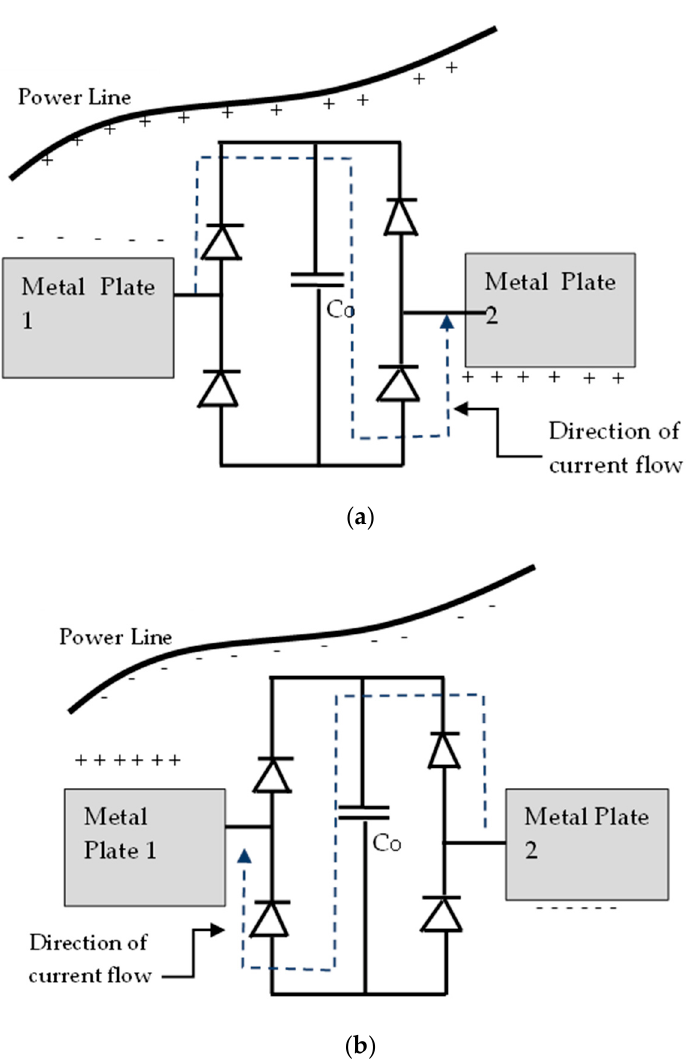
Figure 1. Induction of charges in the metal plates having different distances from the power line. Plate 2 is at a larger distance compared to plate 1. ( a ) Charge induced during +ve half cycle and ( b ) charge induced during -ve half cycle.